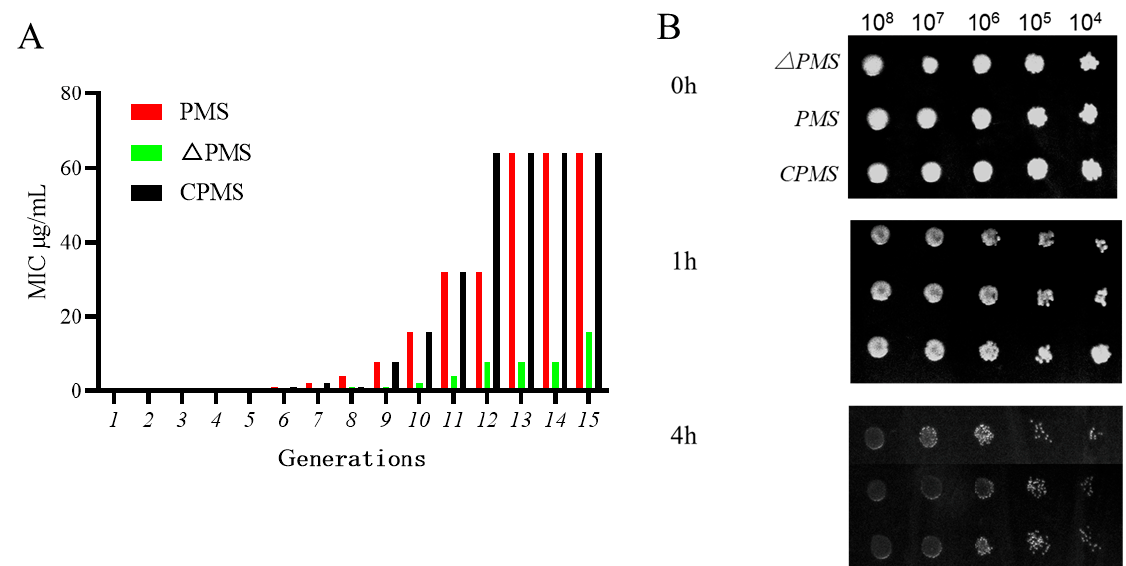
Figure 3. Effect of satP deletion on drug resistance formation and tolerance formation. ( A ) Development time of fluoroquinolone resistance of PmS, Δ PmS and CPmS , induced by sub-inhibitory concentrations of enrofloxacin . ( B ) Tolerance test of Δ PmS to enrofloxacin microdilution method.